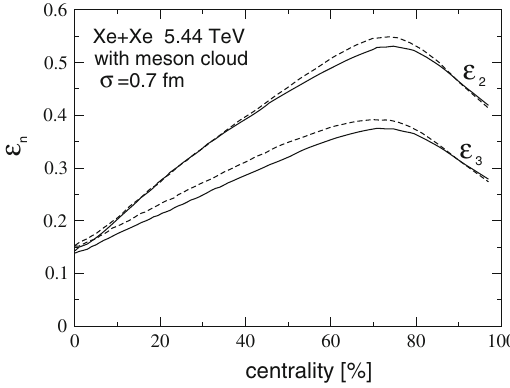
√ s = 5 . 44 TeV (right) for the θ -dependent Woods–Saxon distribution with (solid) and without (dashed) the hard-core